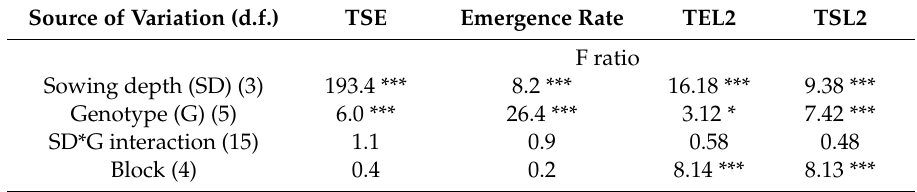
Table 2. Test-tube experiment. ANOVA for average time from sowing to emergence (TSE), emergence rate, time from emergence to second leaf (TEL2), and time from sowing to second leaf (TSL2). Source of Variation (d.f.)